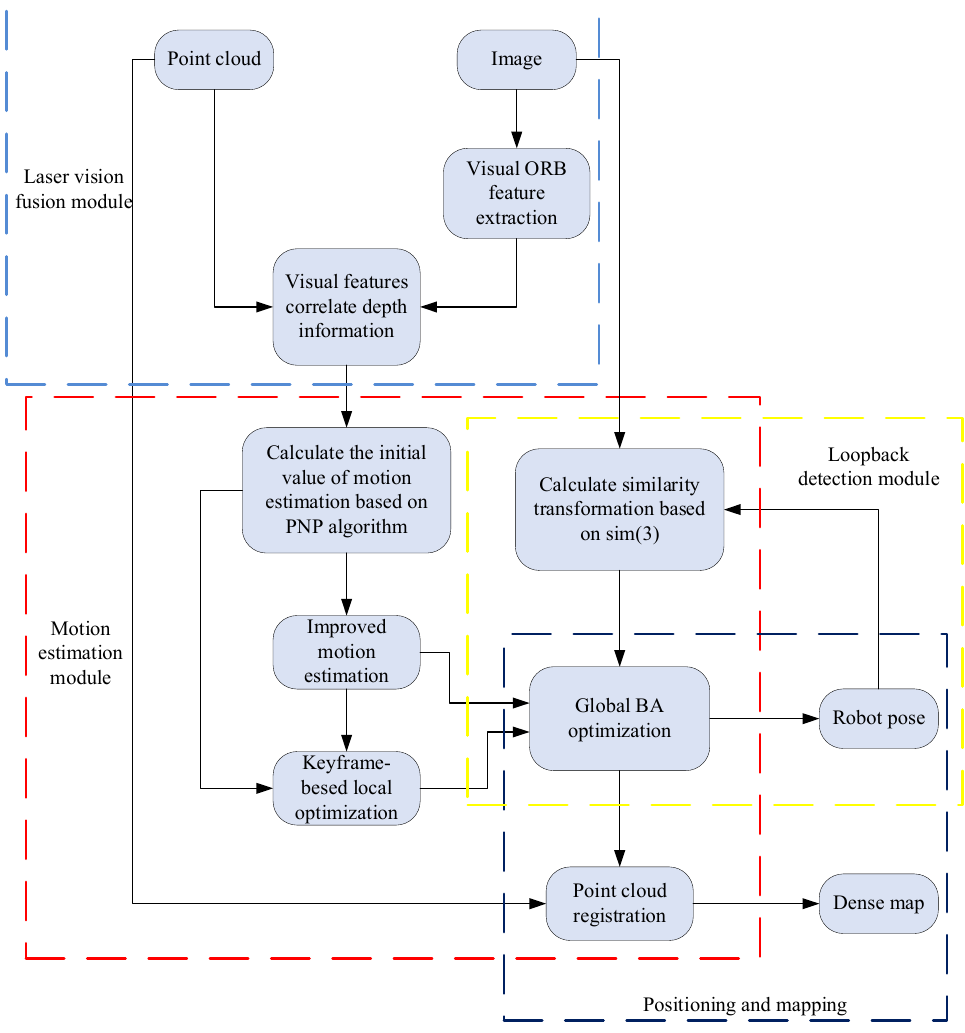
Figure 1. SLAM framework for image and laser point cloud fusion. Firstly, the external parameters of the camera and lidar sensor are calibrated. The laser point cloud is projected into the image coordinate system using the calibrated external parameter information. The ORB features are extracted from each frame. In the